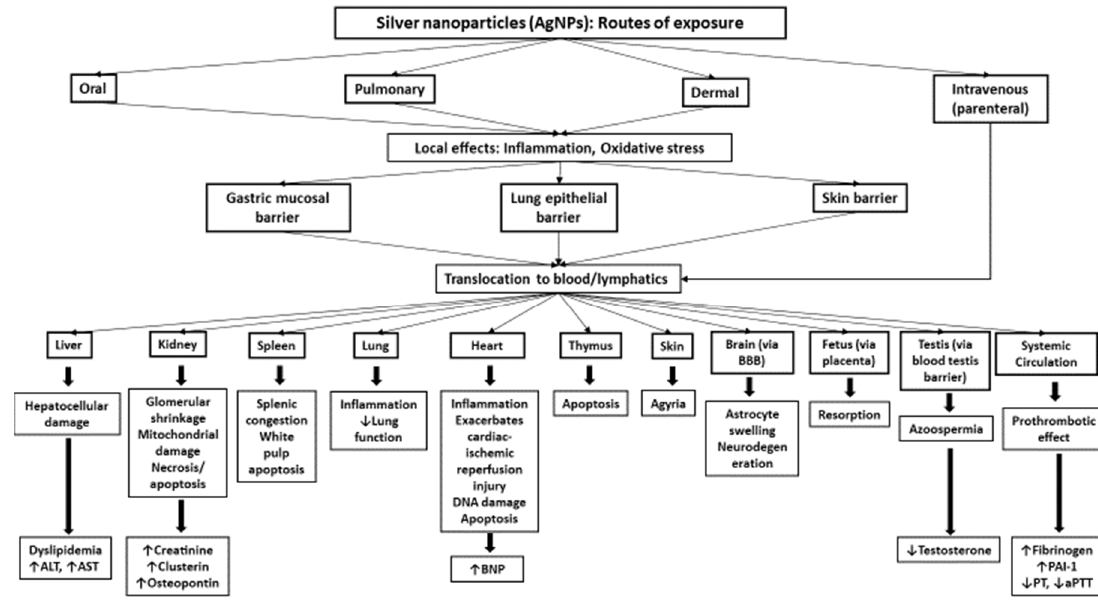
Figure 1. Schematic representation of the biodistribution and toxicity of silver nanoparticles (AgNPs) 242 following various routes of exposure. 243